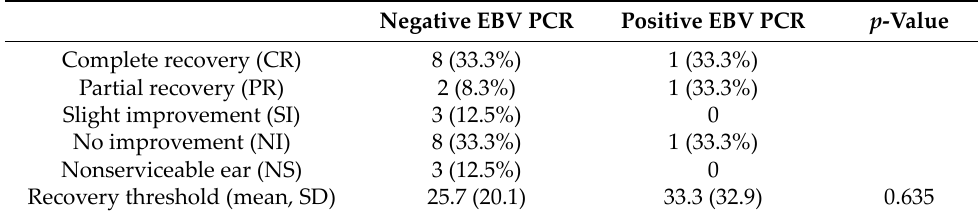
Table 2. Hearing outcomes.